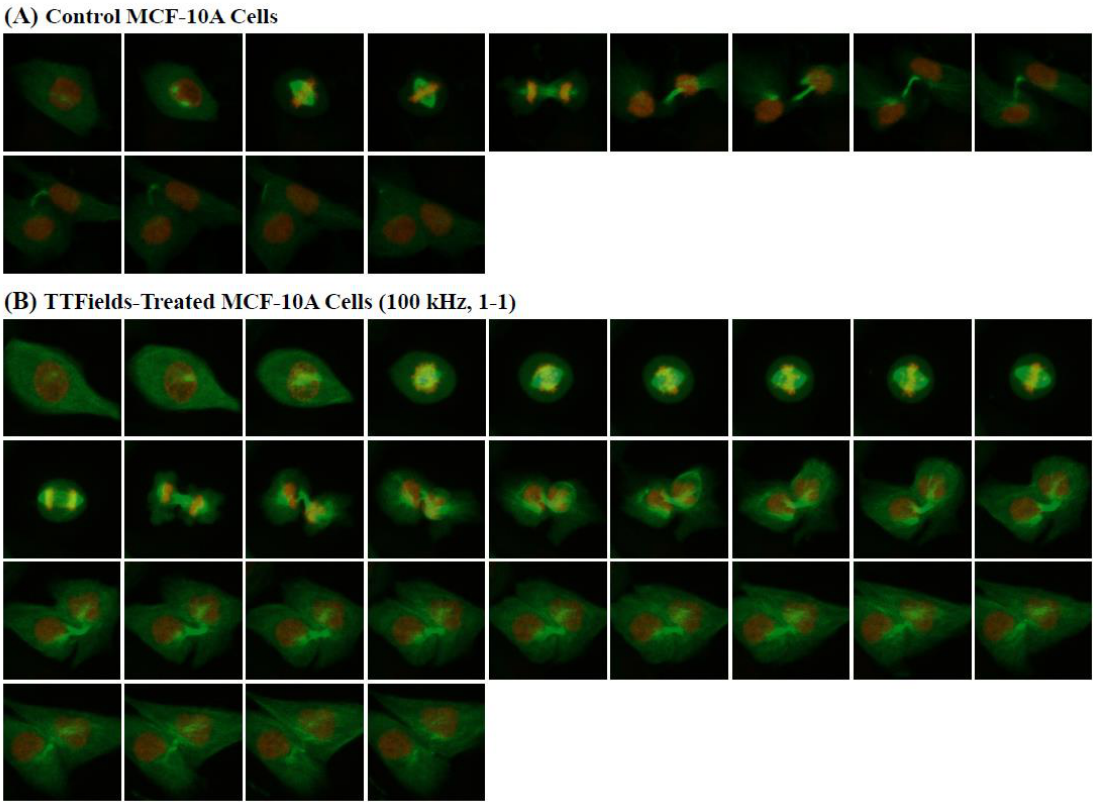
Figure 5. A total of 3 × 10 4 MCF-10A cells were seeded on a coverslip of a 35 mm ibidi dish and allowed to adhere overnight. Cells were synchronized in the G1/S phase by a single thymidine block and then released for 6 h before imaging. Cells were maintained in an atmosphere of 5% CO 2 with an ambient temperature of 37 °C for the control cells and 23 °C for the TTFields-treated cells. ( A ) Representative images of unexposed MCF-10A cells acquired every 10 min throughout cell division. ( B ) Representative images of TTFields-treated MCF-10A cells (100 kHz, 1-1 duty cycle) acquired every 10 min throughout cell division.